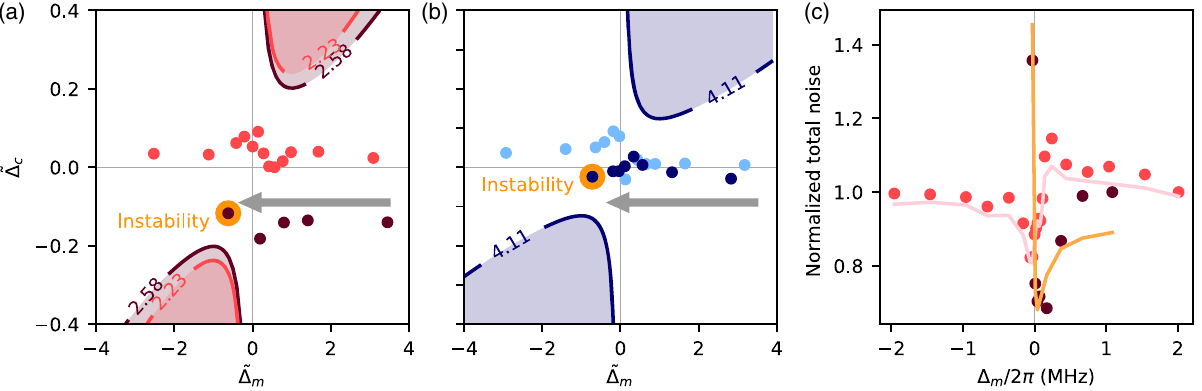
FIG. 7. Two-tone instability in the optical domain. (a) Two-tone BAE measurements (dark red and light red dots) scanning Δ ˜ Δ ˜ Δ ; kept approximately constant. The ð coordinate of each measurement is plotted. The instability contours for the respective m c Þ cooperativities, around C ∼ 2 . 2 – 2 . 6 (contour label), are indicated with the same color. While one measurement sequence ( C ¼ 2 . 23 ) ˜ Δ ≈ 0 , the other ( C ¼ 2 . 58 ) encounters instability in the vicinity of its corresponding contour. The highlighted dot is the remains near c measurement right before instability. (b) Same as (a) with higher C ∼ 4 . 1 . Here the stable region is smaller, highlighting the difficulty of ˜ Δ achieving stable operation due to the inaccuracy in . (c) Total noise power in the mechanical sidebands, normalized to 1 for large Δ c for the two measurements sequences in (a). The sudden increase in power for the unstable data is evident. The solid lines are theoretical fits using the full Langevin equations. See text for more